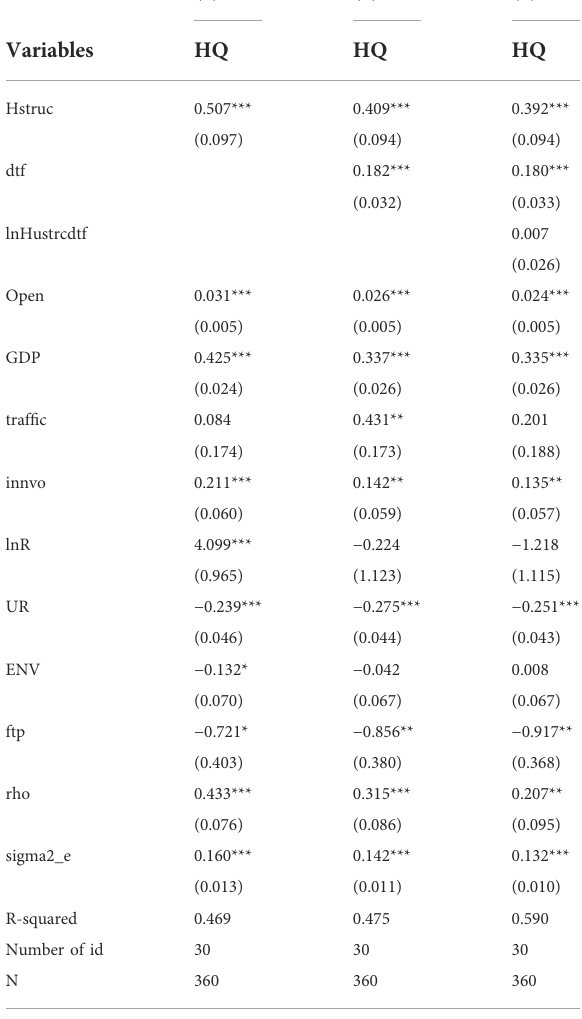
TABLE 14 Robustness checks: the Durbin model based on geographic distance spatial